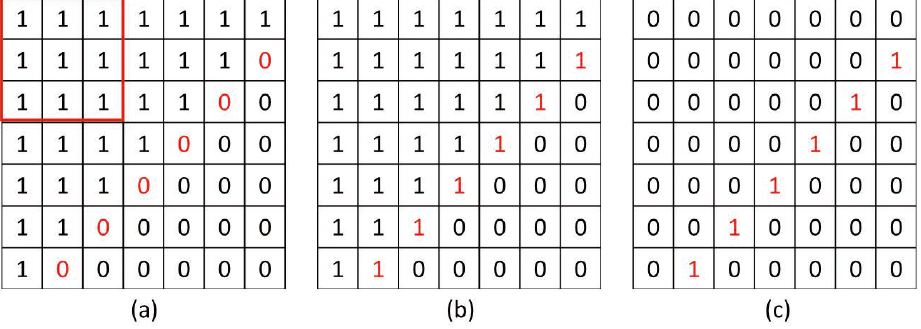
Figure 5. An example of extracting edge from binary image. ( a ) A 7 × 7 binary image using a 3 × 3 maxpooling with the SAME type of padding and the stride of 1. ( b ) The spatial gradient map of the 7 × 7 binary image. ( c ) The 7 × 7 edge